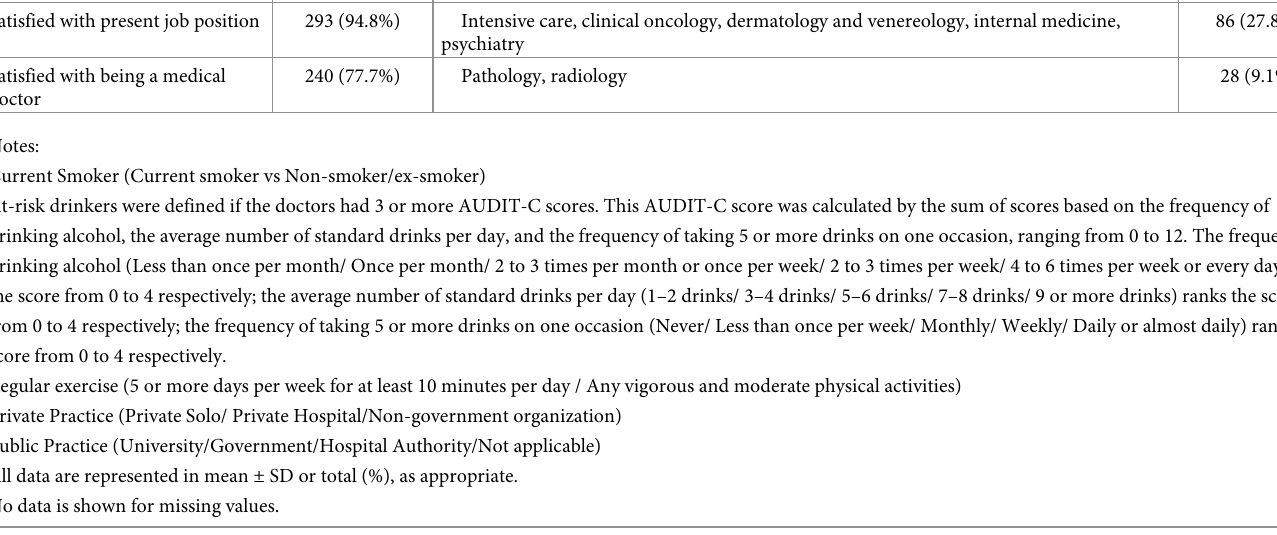
were at-risk drinkers. The mean number of chronic illnesses was 0.2 (SD = 0.5), and 77.7% of participants exercise regularly.